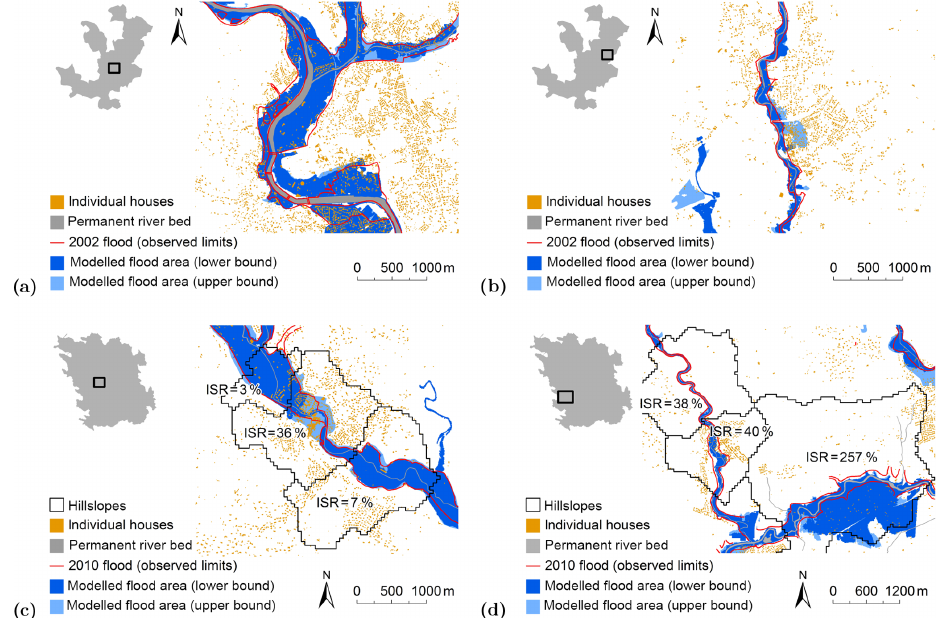
Figure 7. Examples of comparison between observed and estimated flood extents, and related ISR values (computed for the lower bounds of estimated flood extents): (a) Alès 2002 event for the Grabieux and Gardons rivers, (b) Alès 2002 event for the Avène river, (c) Draguignan 2010 event for the Nartuby river, and (d) Draguignan 2010 event for the Florieye and Argens